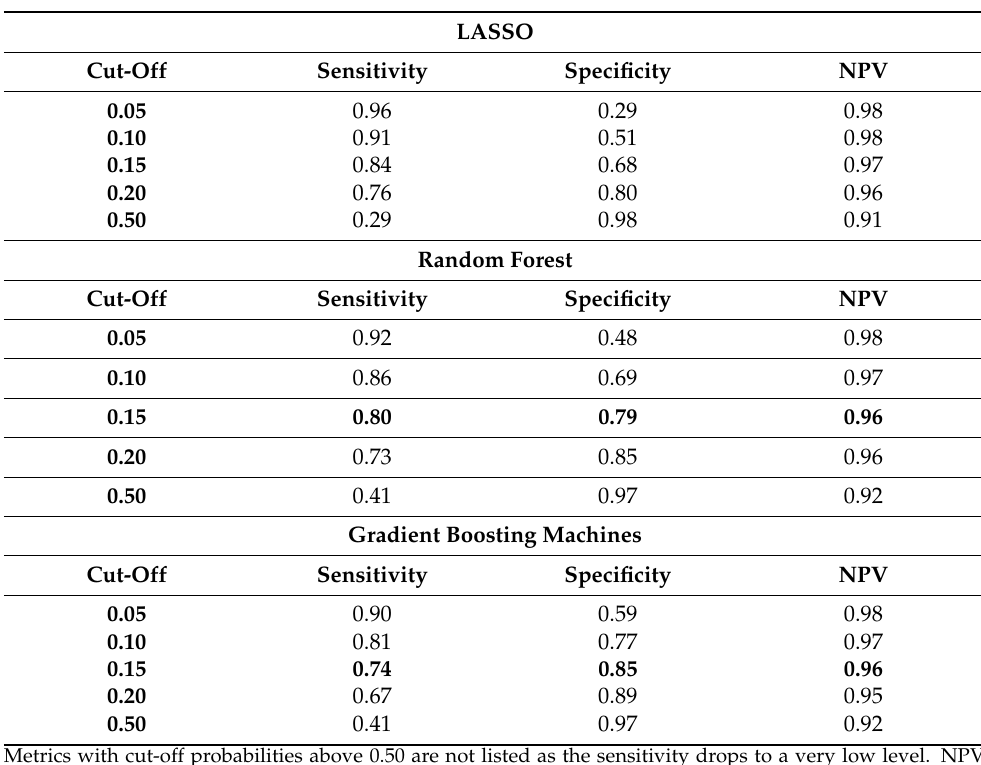
Table 4. Sensitivity, specificity, and NPV by varying cut-off in Lasso, Random Forest and Gradient Boosting